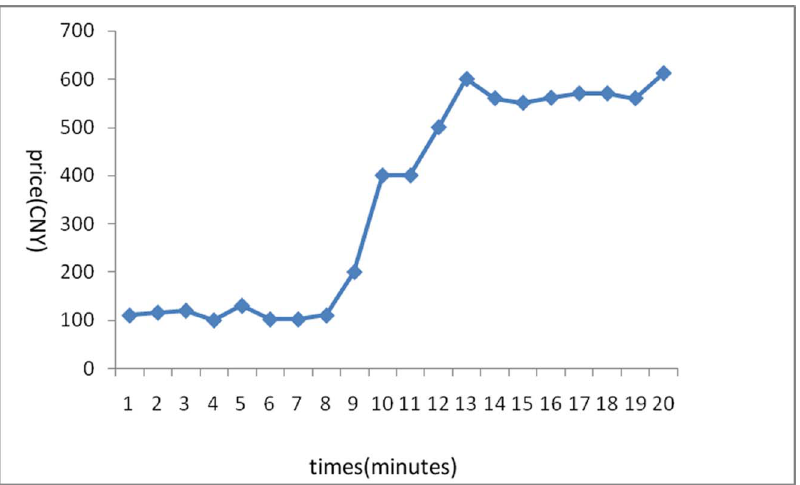
Figure 3. Third Experiment of a Unilaterally Price-Rising Situation with Manipulation.